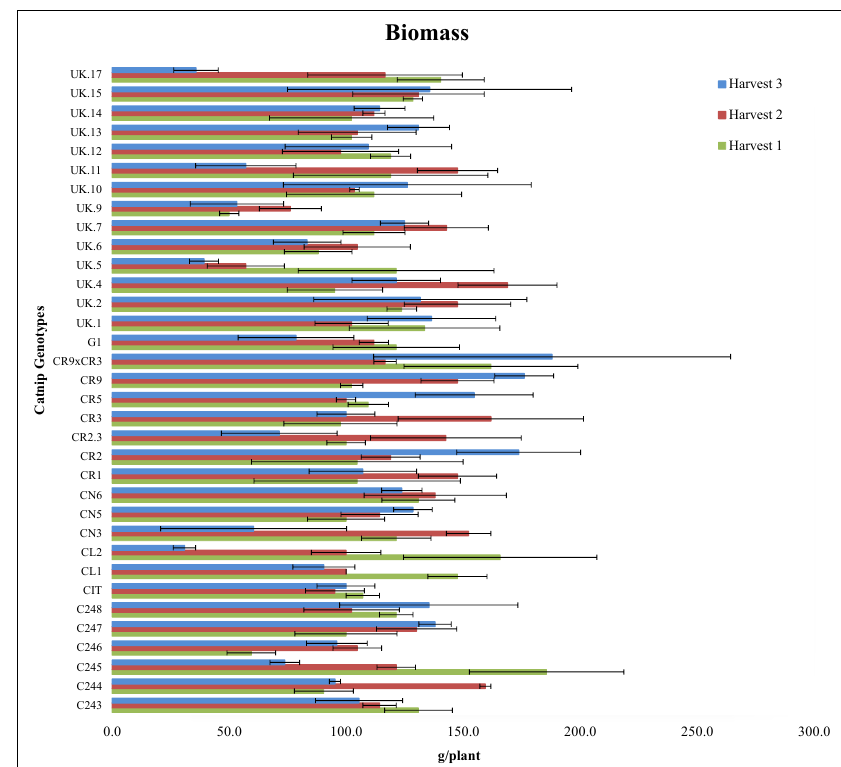
Figure 1. Dry biomass (g/plant) of catnip genotypes at three different harvest times. Pittstown, NJ, USA, 2017 and 2018. Error bars represent standard errors. Harvest 1 = July 2017, Harvest 2 = September 2017, Harvest 3 = June 2018. Detailed statistical analyses of the interaction effects are presented in the Supplementary Material Table